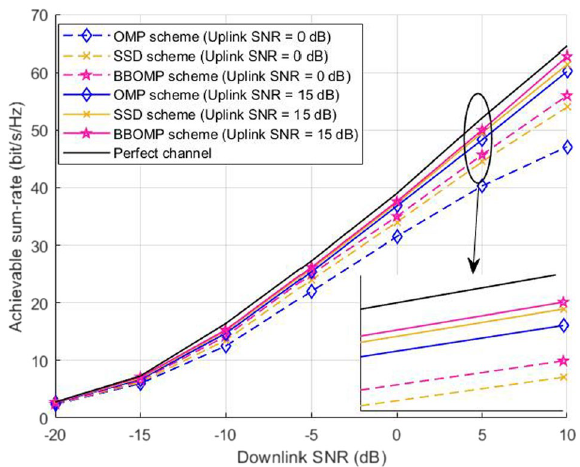
Fig. 10 Achievable sum-rate comparison against SNR for data transmission